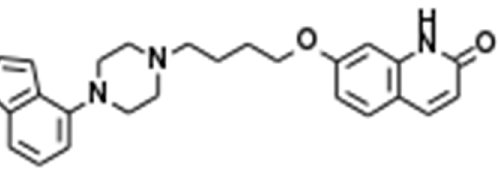
Figure 1. Chemical structure of brexpiprazole (Brex), 7-[4-[4-(2,3-Dichlorophenyl)-1-piperazi-